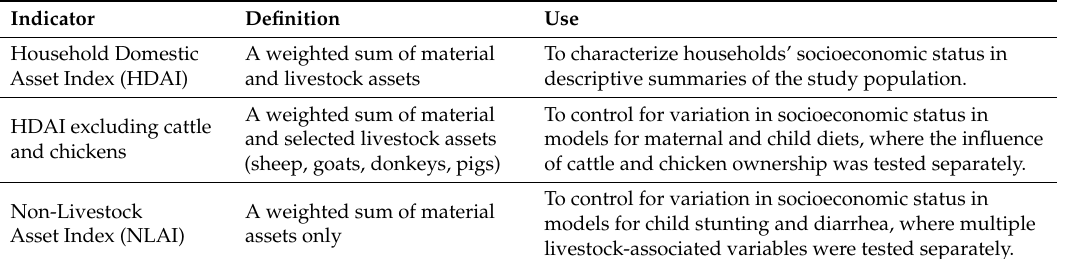
Table 1. Indicators to represent household socioeconomic status in this